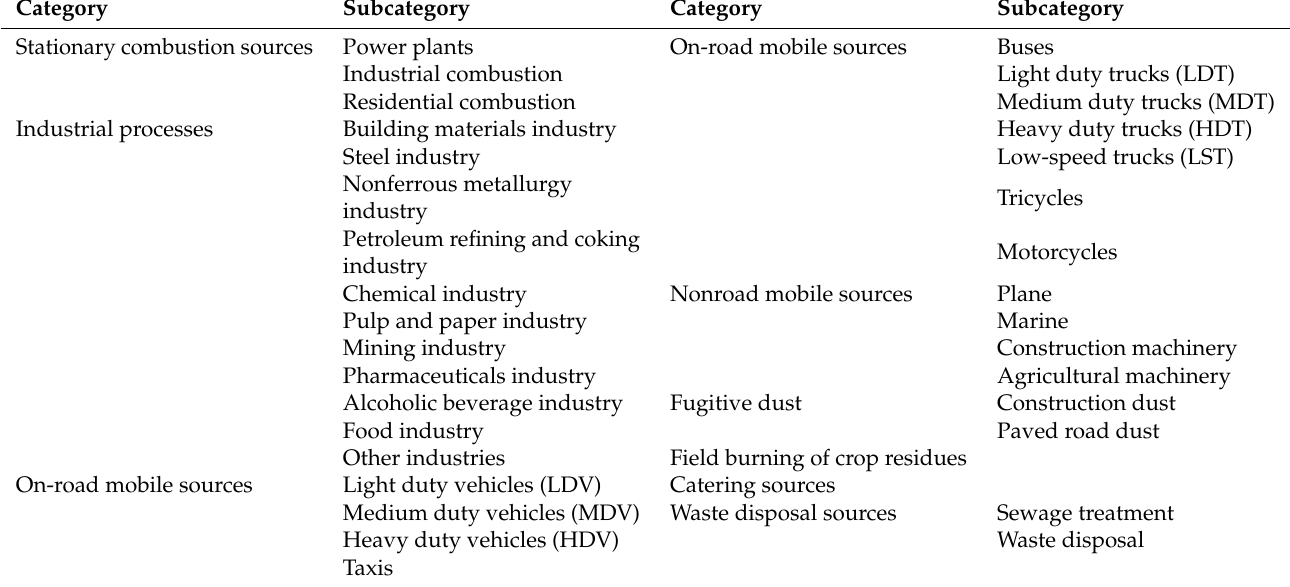
Table 2. Emission source categorization in Sichuan